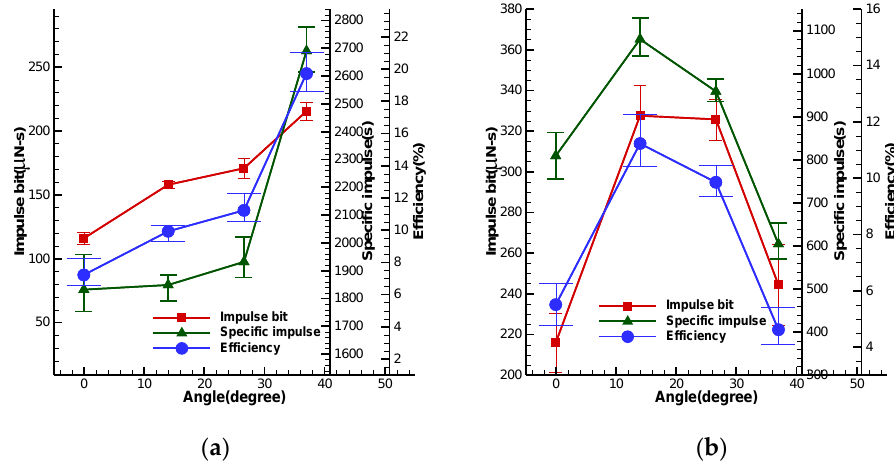
Figure 12. The APPT performance of tongue-shaped electrodes with variable flare angles: ( a ) the electrode spacing is 3 mm and ( b ) the electrode spacing is 25 mm.